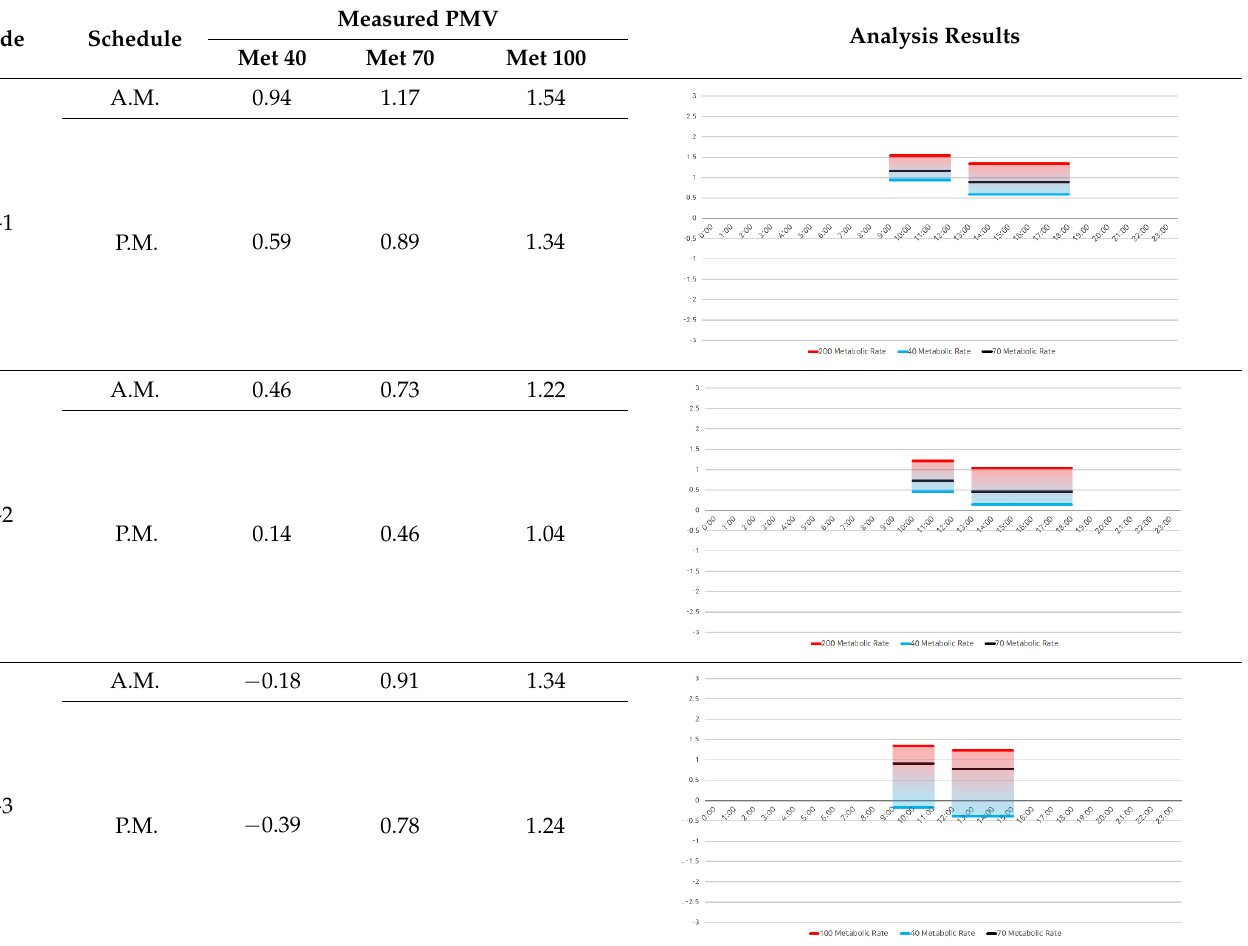
Table 6. Calculated PMV ranges per operation schedule for target Hanoks.